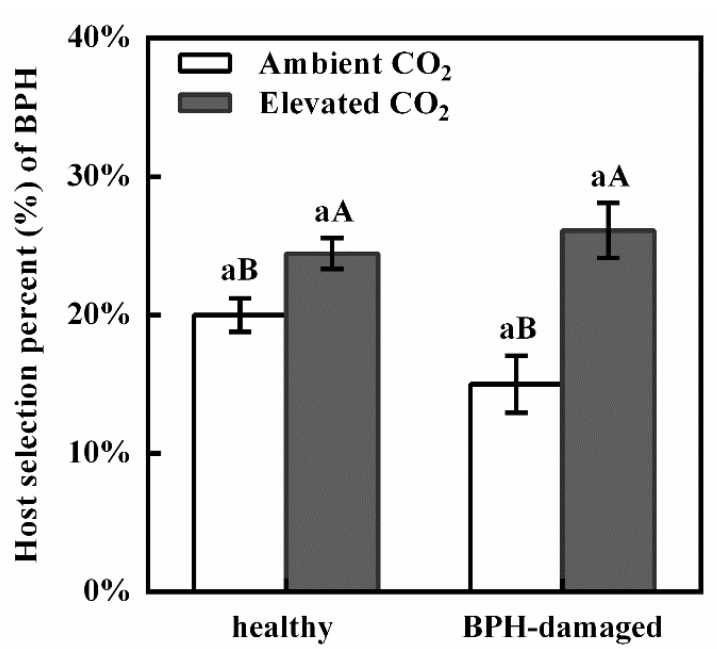
Figure 1. The host selection rate (%) of the adults of brown planthopper (BPH), Nilaparvata lugens, for the healthy and BPH-damaged rice plants grown under ambient and elevated CO 2. ( Note: Different uppercase and lowercase letters indicate significant differences between ambient and elevated CO 2 level, and between the healthy (CK) and BPH-damaged rice plants by the independent sample t -test at p < 0.05, respectively).